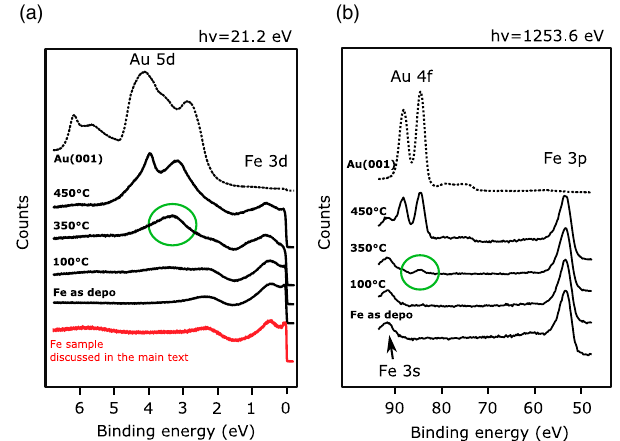
FIG. 6. Results of the chemical characterization of the Fe surface. A 100-ML Fe film was deposited at 50 K and annealed in steps to the indicated temperatures. (a) UPS spectra measured along normal emission using He emission line ( h ν ¼ 21 . 2 eV). The red spectrum (bottom of the figure) was collected during the measurements described in the main part of the article. The dotted spectrum at the top represents clean Au(001) surface. (b) Simul- taneously collected XPS